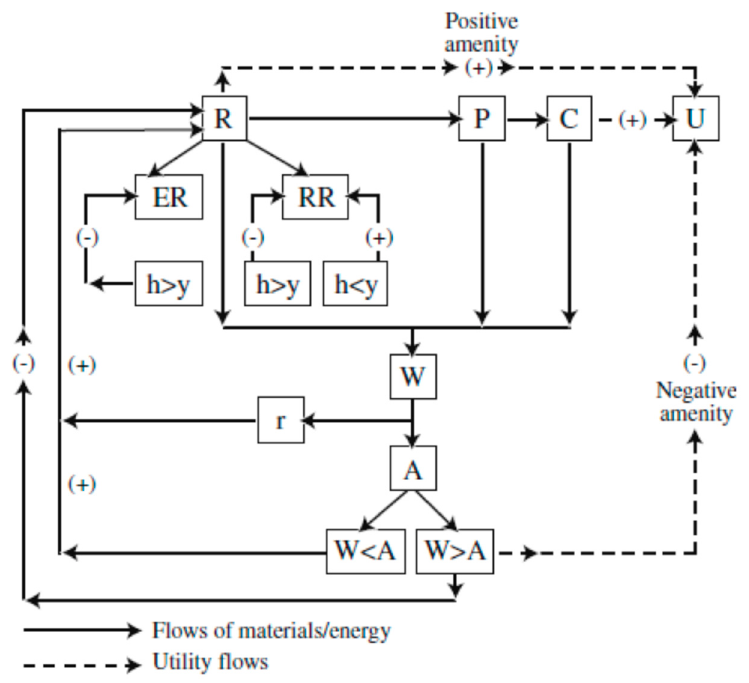
Figure 3. Circular economy processes. Source: Pearce and Turner [32]. r—Recycling, P—Production, C—Consumption, U—Utility, K—Capital goods, R—Natural resources, ER—Exhaustible resources, RR—Recyclable resources, A—Assimilative capacity, W—Waste, h—Harvest, y—Yield.